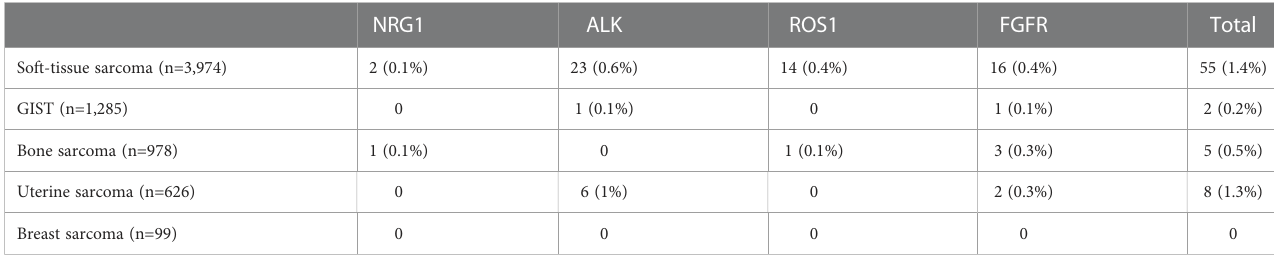
TABLE 4 Prevalence of gene fusions being investigated as potential histology-agnostic predictive biomarkers in sarcoma samples in the AACR GENIE database v12.0-Public.